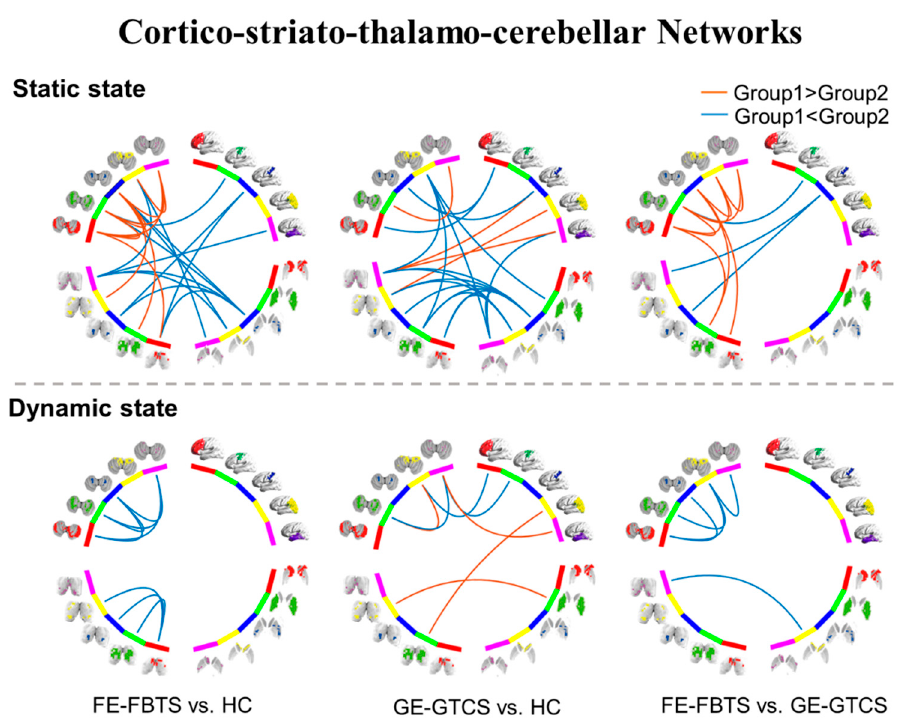
Figure 2. Group comparisons of cortico-striato-thalamo-cerebellar networks between three groups in static and dynamic state. Red: frontal lobe, Green: motor/premotor, Blue: somatosensory, Yellow: partial–occipital, Violet: temporal lobe.